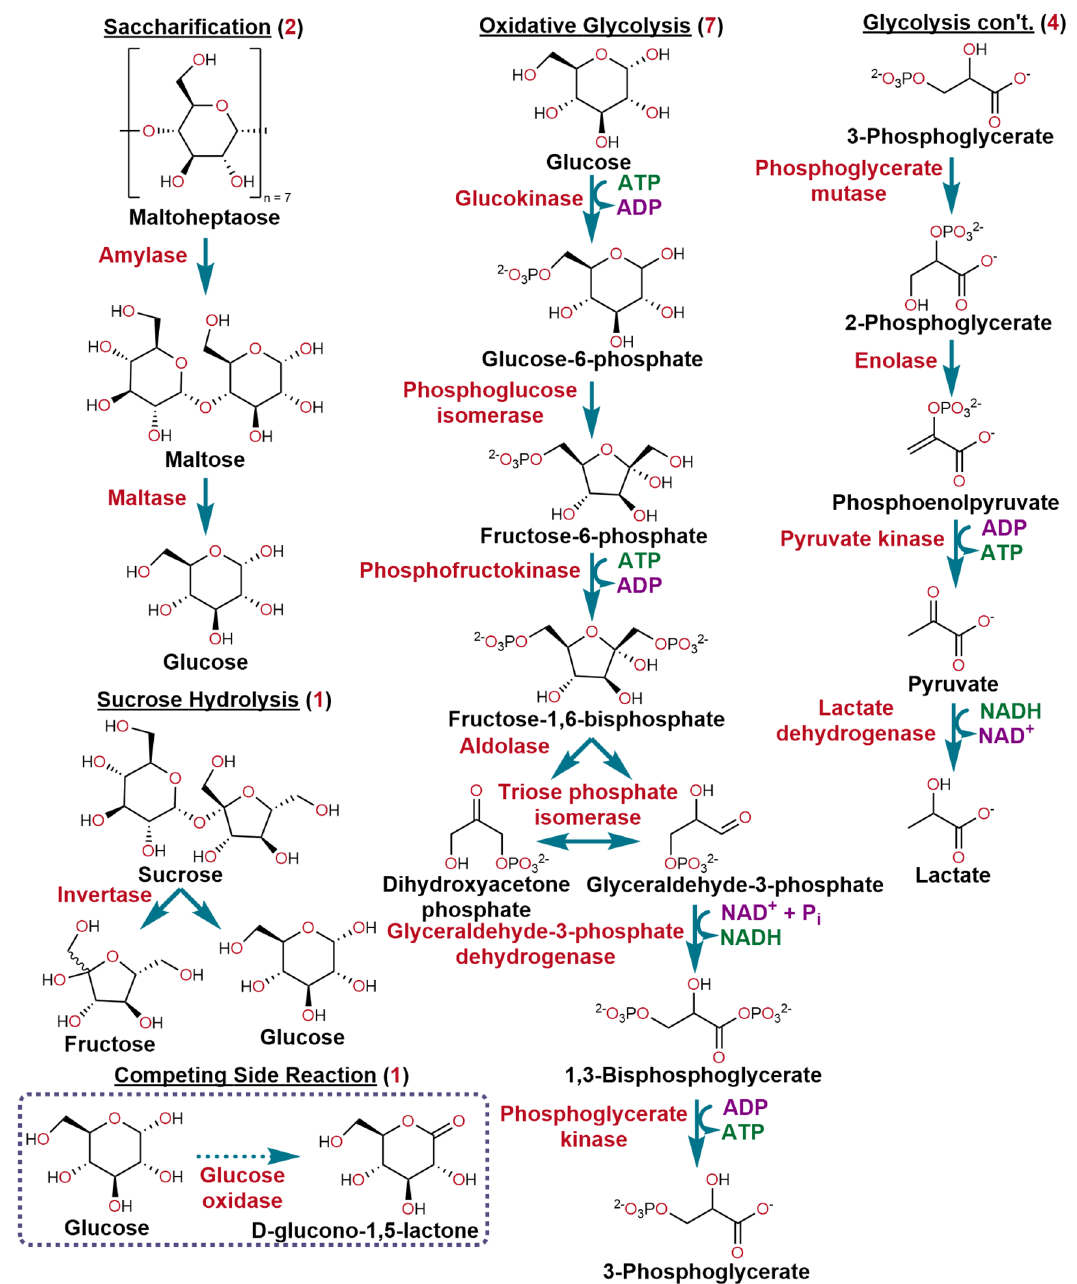
Fig. 2 | Enzyme pathways utilized in this study. The primary 7 enzyme (7E) pathway processes glucose to 3-phosphoglycerate (3-PG) and this is extended by addingupstreamsacchari fi cationofamyloseorsucrosetoglucose.The4enzymes processing 3-PG to yield lactate constitute a second downstream cascade. The cascadesterminatingintheproductionof3-PGwereassayedbymonitoringNADH formation, while those utilizing 3-PG to produce lactate followed NADH consumption 55,56 . Glucose oxidase is used in a competitive reaction format to test for channeling. Enzymatic steps are indicated in blue, enzyme names in red,